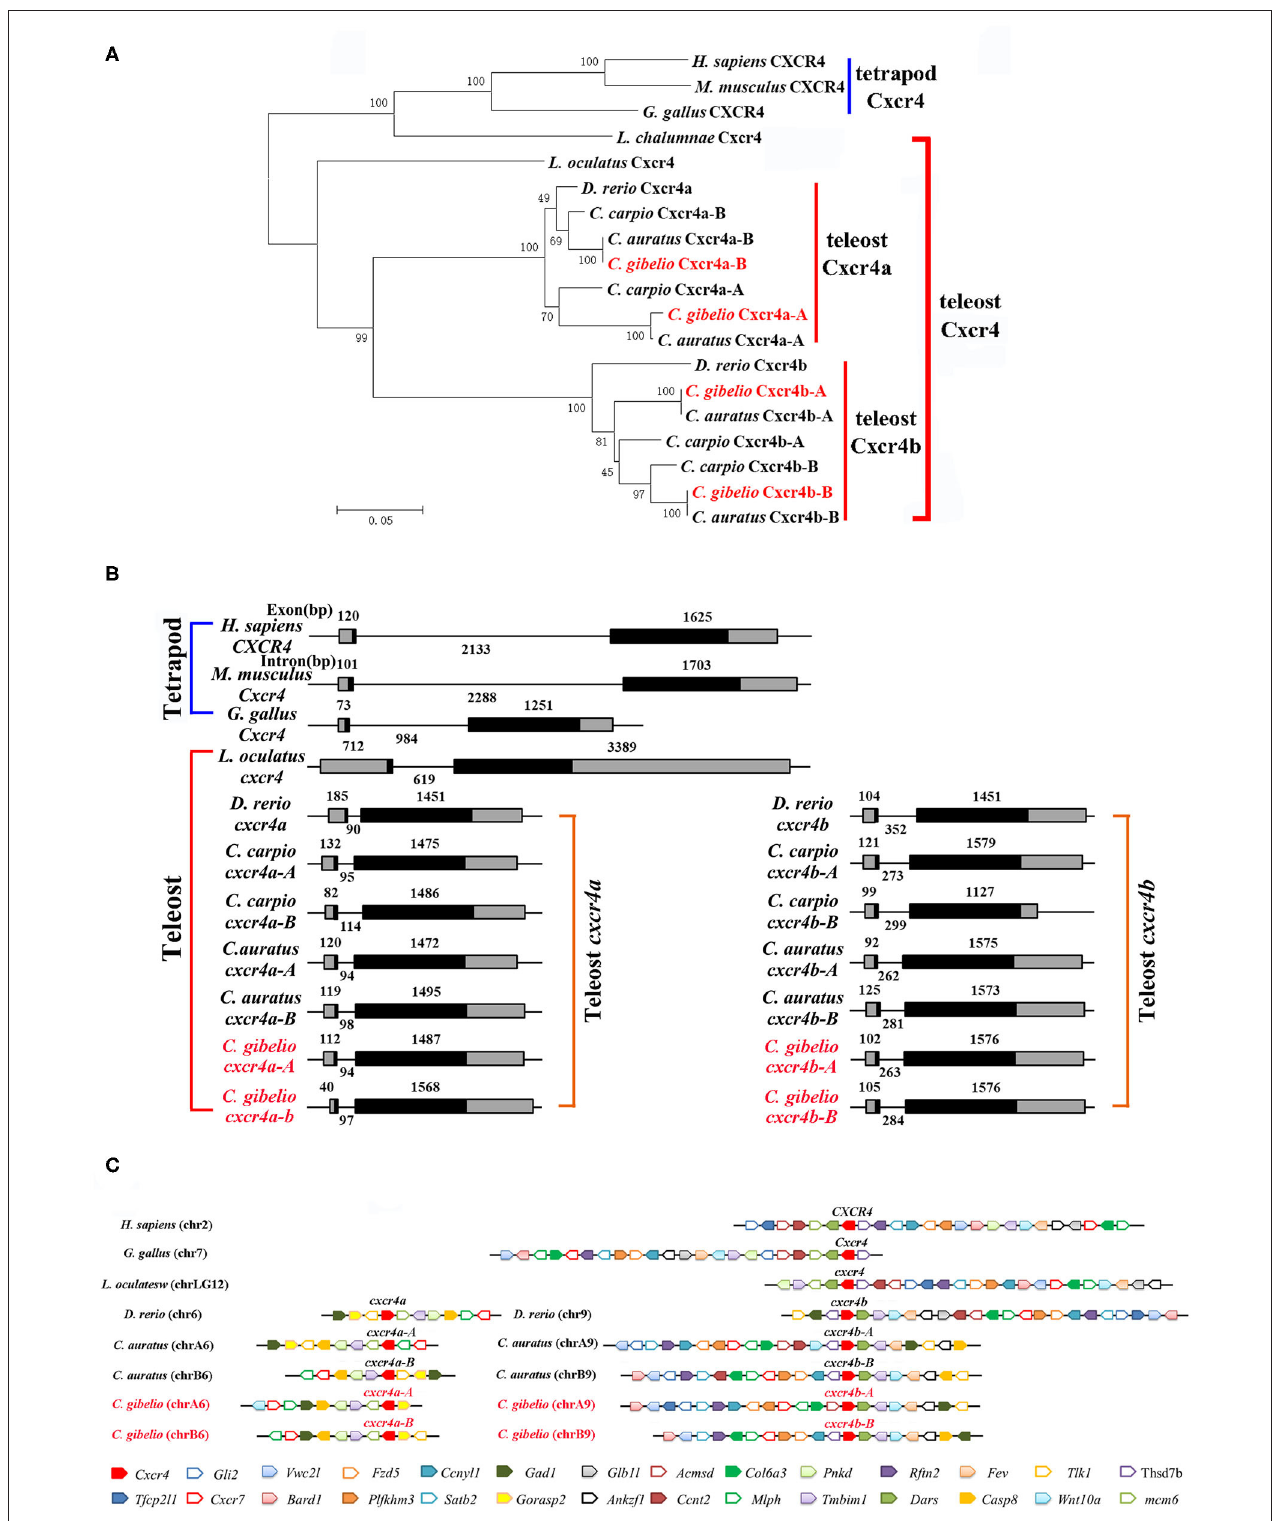
FIGURE 1 | Evolutionary analyses of multiple divergent cxcr4 genes. (A) Phylogenetic tree of Cxcr4 proteins. (B) Genomic structures of cxcr4 genes. Exons and introns are shown by boxes and horizontal lines, respectively. ORFs are highlighted by black boxes. Exon and intron size are indicated above or below as bp. (C) Syntenic alignment of chromosomal regions around cxcr4 genes. Chromosome segments are represented as thick lines. Conserved gene blocks are shown in matching colors and transcription orientations are indicated by arrows. Chr, chromosome.